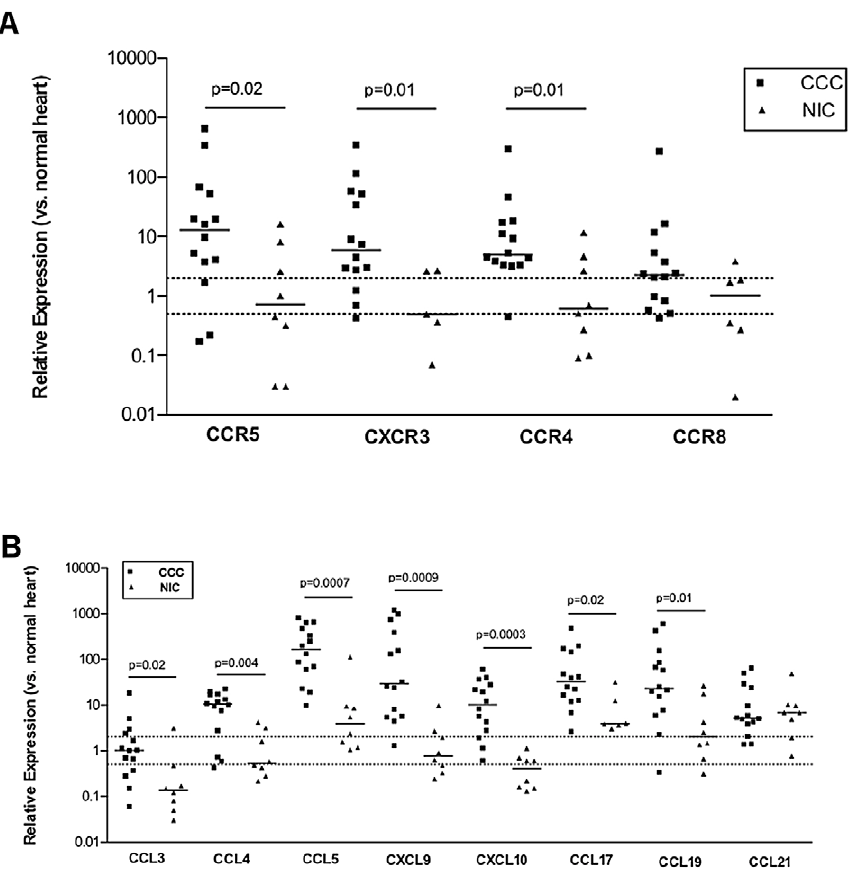
Figure 2. Expression of chemokines and chemokine receptors in myocardium. Expression of chemokine receptors (A) in CCC and NIC myocardium. Expression of chemokines (B) in CCC and NIC myocardium. Real-time qPCR analysis of mRNA levels expression in CCC and NIC myocardium. After normalization to GAPDH mRNA, the relative expression was plotted in comparison to N group and data were calculated with the 2 2 DD Ct method, as described in Methods. The horizontal bar stands for the median. Dotted lines indicate two-fold increase or decrease expression as compared with the control group.